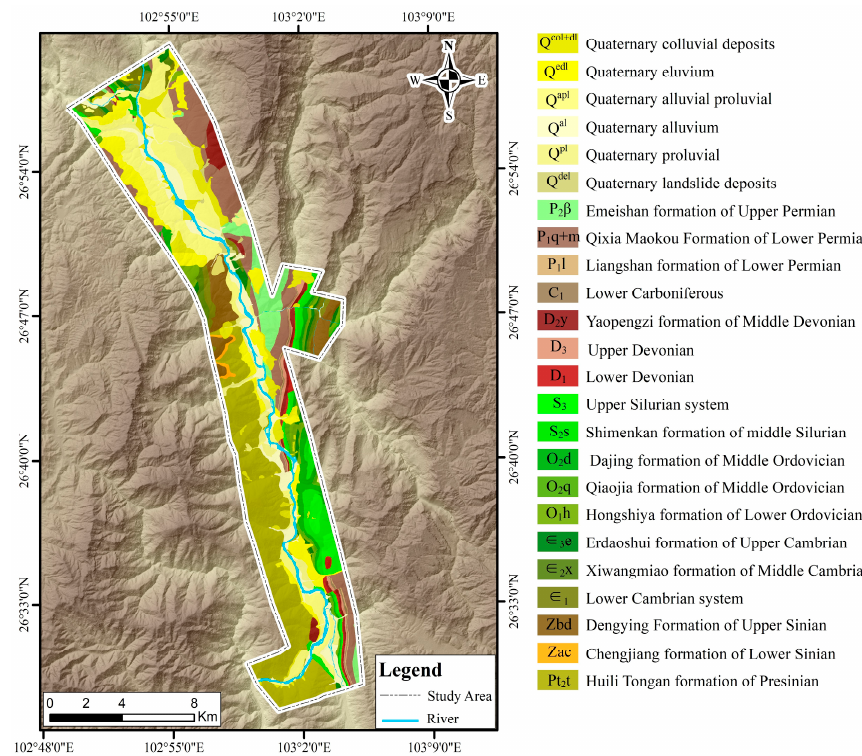
Figure 2. Regional geological map of the study area.